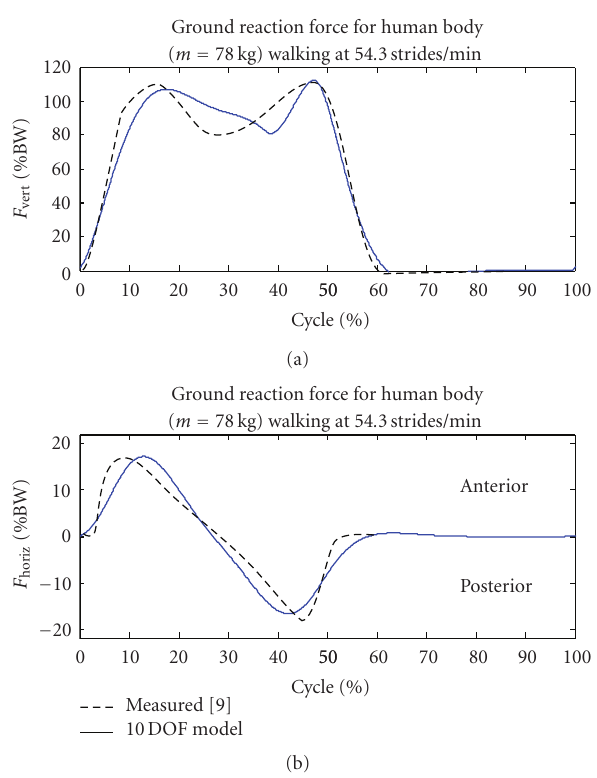
Figure 18: Ground reaction force calculated using the distributed mass model and compared to the measured force using the force plates method